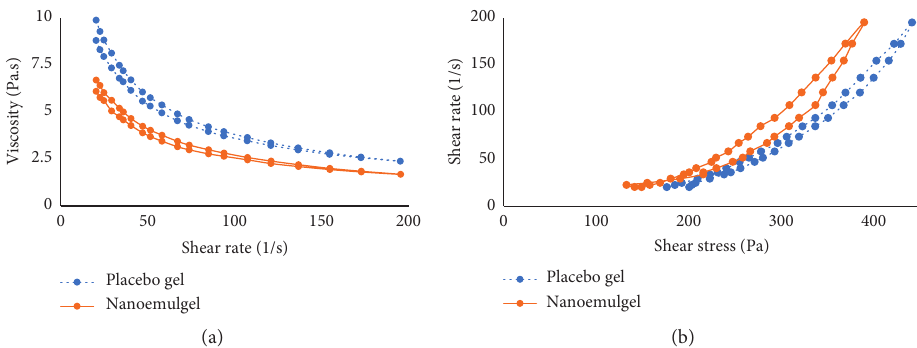
Figure 5: Rheological profile of 0.5% (w/v) of Carbopol 980 placebo gel and nanoemulgel: (a) viscosity verses shear rate; (b) shear rate verses shear stress.